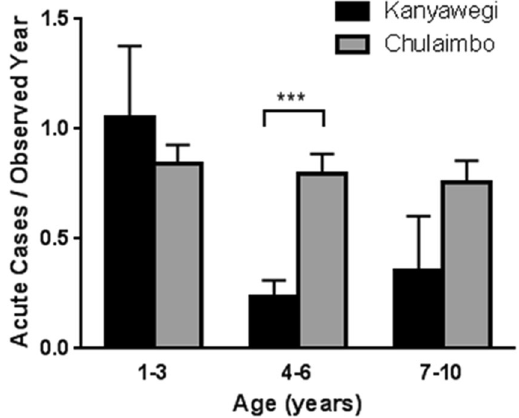
Figure 1. Mean number of acute uncomplicated malaria cases among children < 10 years old per observed year in the 2003 Kanyawegi and 2013 Chulaimbo cohorts with 95% CI. Statistical significance was determined within age groups by independent t-test. *** p <